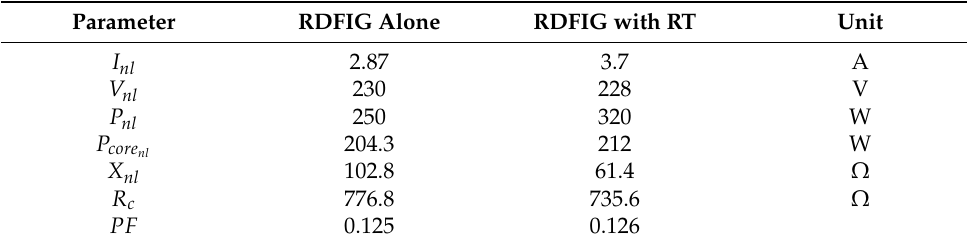
Table 7. Rotary transformer–RDFIG no-load tests.